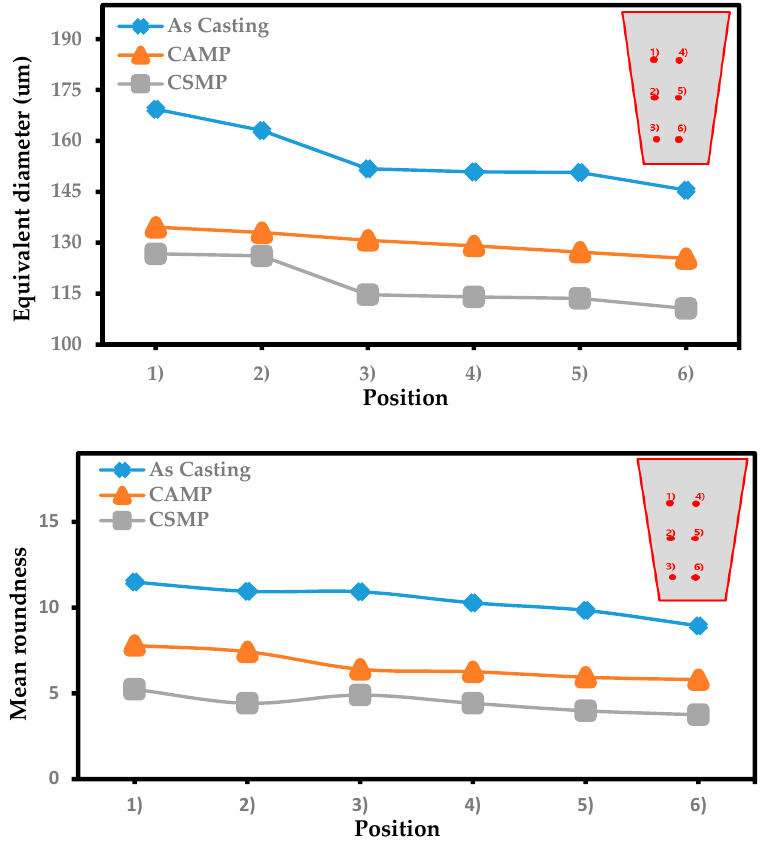
Figure 8. Equivalent diameter and roundness by A356 alloy.